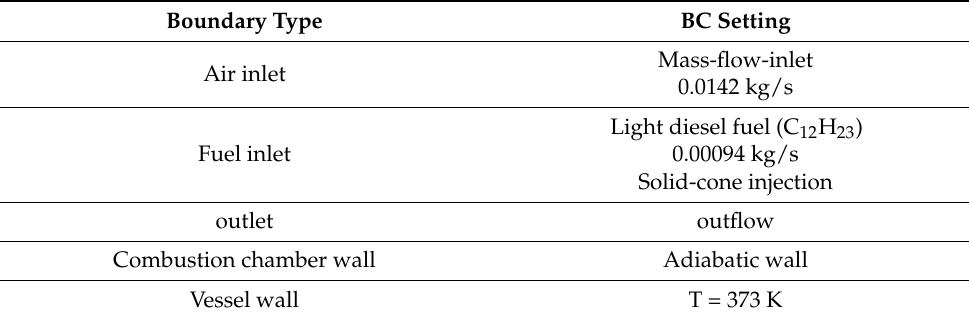
Table 1. Boundary conditions at 40